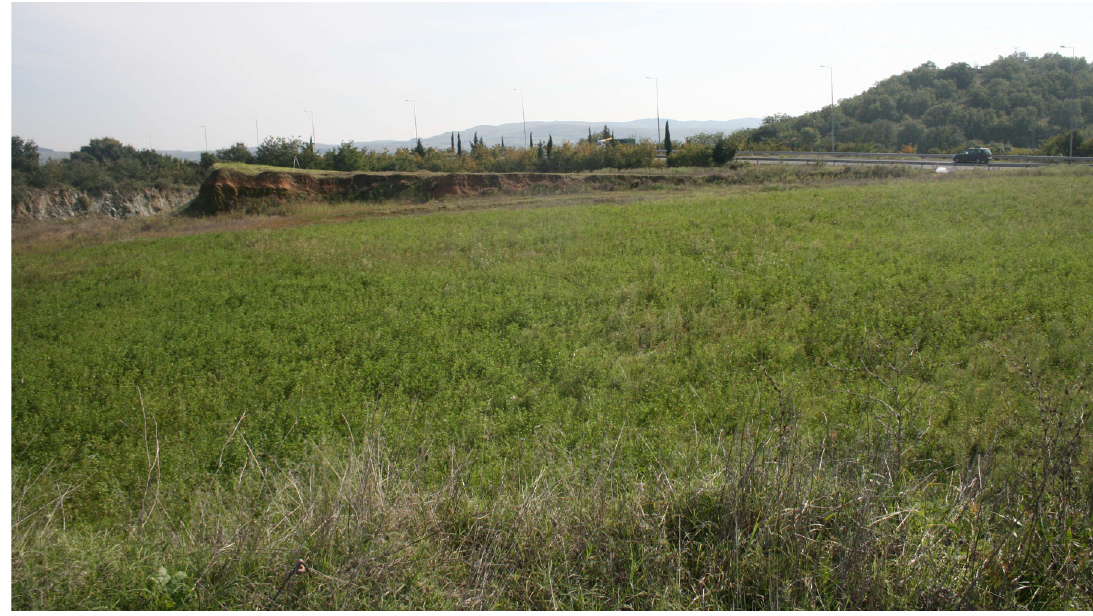
Figure 17. The archaeological site at Idomeni and the Dogani hill (Chemin de Fer) (archive of the Ephorate of Antiquities of Kilkis, photo Stamatis Chatzitoulousis).